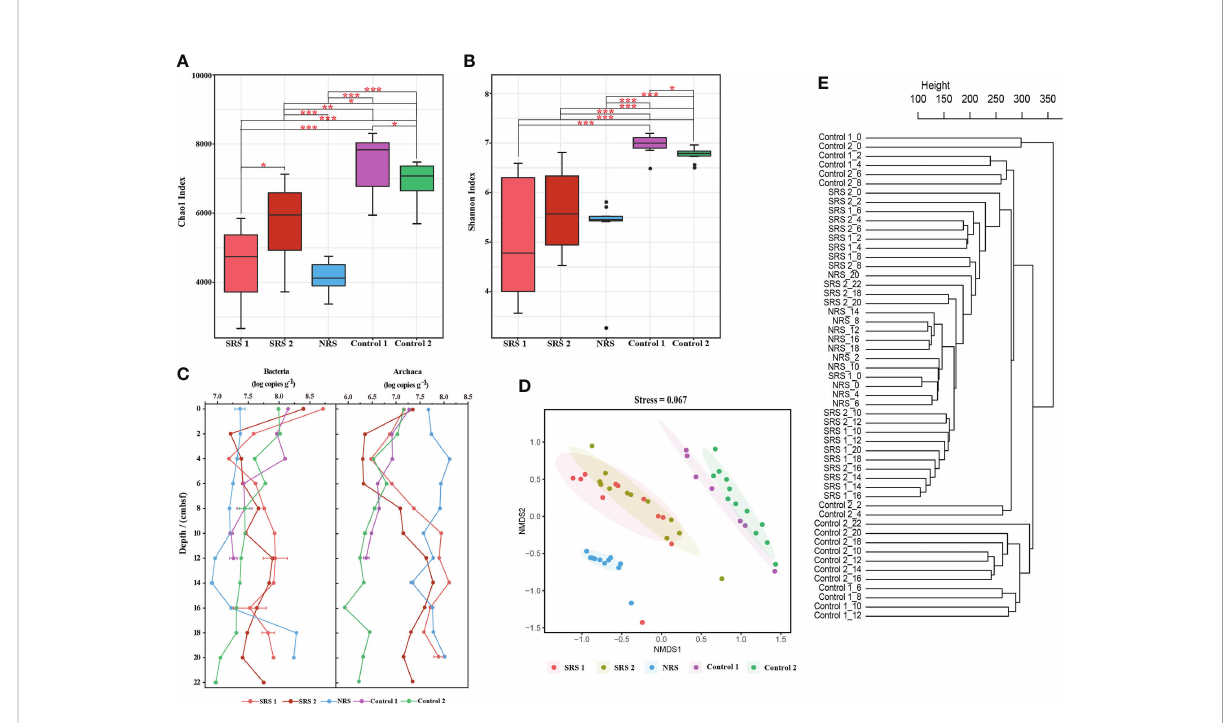
FIGURE 2 The a -diversity and b -diversity indices, as well as 16s rRNA gene abundance of all samples. (A) Horizontal Chao1 index at the OTU level. (B) Horizontal Shannon index at the OTU level. (C) Horizontal and vertical changes of bacterial and archaeal 16S rRNA gene abundance. (D) Non- metric multidimensional scaling ordination of microbial communities based on the Bray – Curtis dissimilarity. (E) Hierarchical clustering of microbial communities based on the Bray – Curtis distances. * 0.01 ≤ P value ≤ 0.05; ** 0.001 ≤ P value ≤ 0.01; *** P value ≤